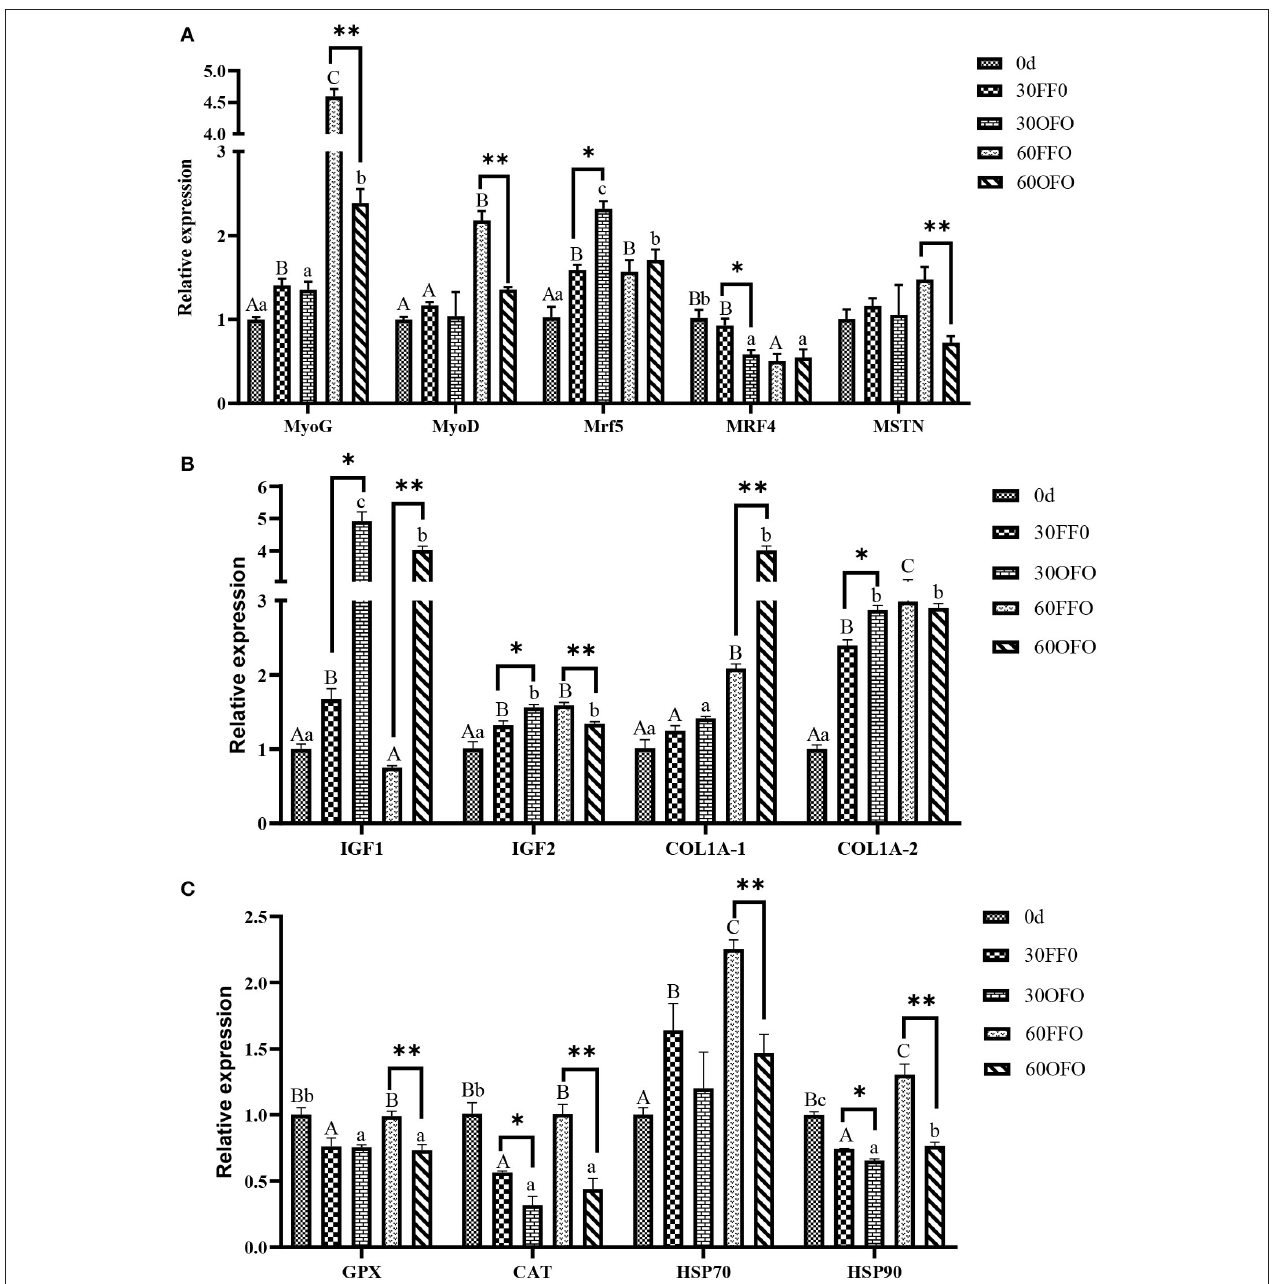
FIGURE 2 | Relative expression of muscle growth factors (A,B) and antioxidant-related genes (C) mRNA of grouper fed different diets. MyoG , myogenin; MyoD , myogenic differentiation; Myf 5 , myofactar5; MRF4 , myogenic regulatory factor 4; MSTN2 , myostatin type 2; IGFl , insulin-like growth factor 1; IGF2 , insulin-like growth factor 2; COL1A1 , collagen type I alpha1; COL1A2 , collagen type I alpha2; CAT , catalase; GPX , glutathione peroxidase; Hsp70 , heat shock protein 70; Hsp90 , heat shock protein 90. Different superscript capital letters in the same row indicate significant differences in the FFO group at different time point, and different lowercase letters indicate significant differences in the OFO group at different time point. *Indicates significant differences of two treatments at 30days, **indicates significant differences of two treatments at 60days ( P <